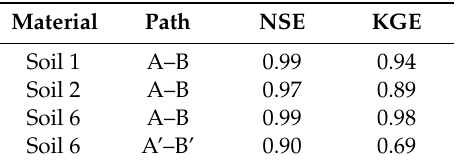
Table 5. Values of Nash–Sutcli ff e E ffi ciency (NSE) and Kling–Gupta E ffi ciency (KGE) for predictions of volumetric water content via the LP hysteresis